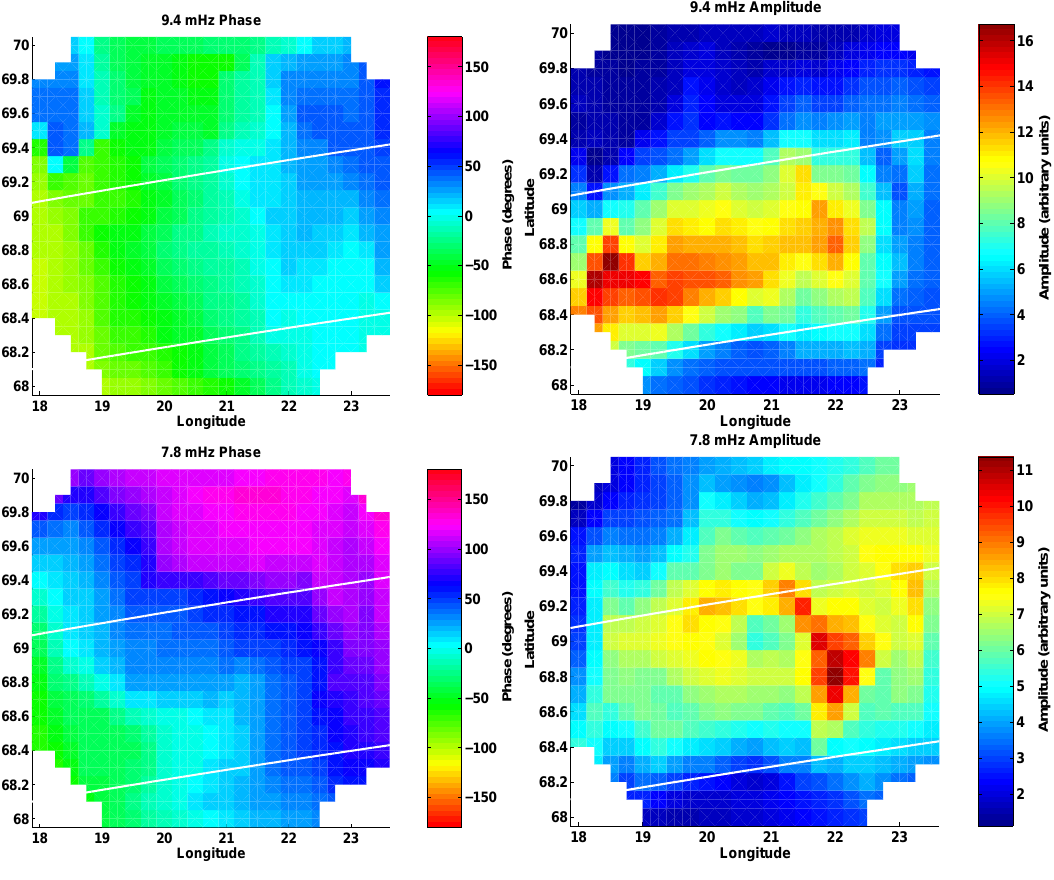
Fig. 7. Maps of the amplitude and phase of the two spectral components of the Pc4 pulsation. The white lines are lines of constant geomagnetic latitude (CGM, 1995 at 90 km). The maps cover the time interval 03:00–03:30